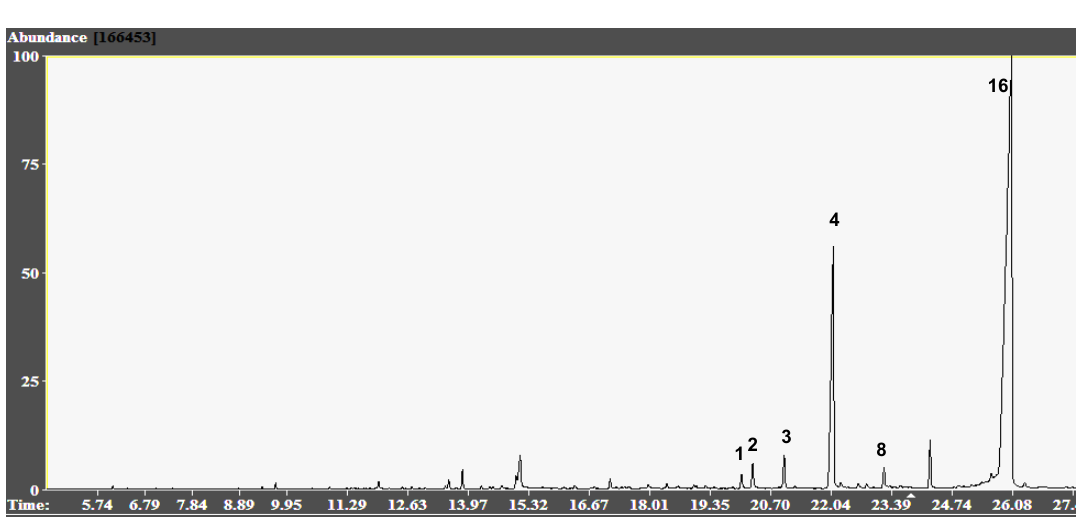
Figure 1. Representative GC-MS Chromatogram of Wild Argentinian Amaryllidaceae BCE- Z. filifolia SJ. Peaks: 1 : Trisphaeridine; 2 : Ismine; 3 : 5,6-Dihydrobicolorine; 4 : Galanthamine 8 : Narwedine; 16 :